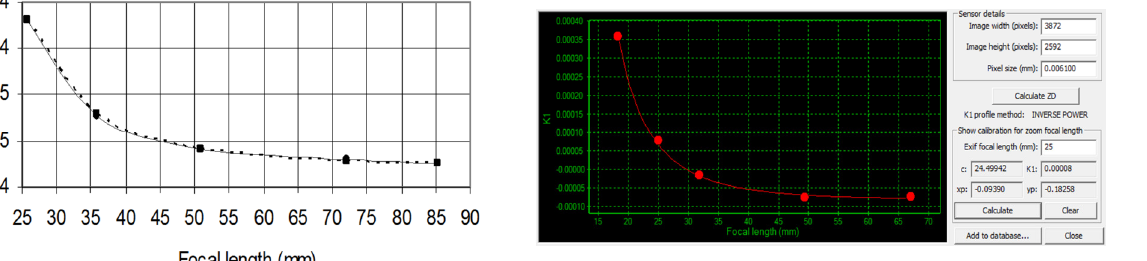
Figure 4. Z-D calibration for a selected EXIF focal Figure 2. Variation of K 1 with changing zoom setting (solid line) and variation function for )( c K (dashed line). 1 i